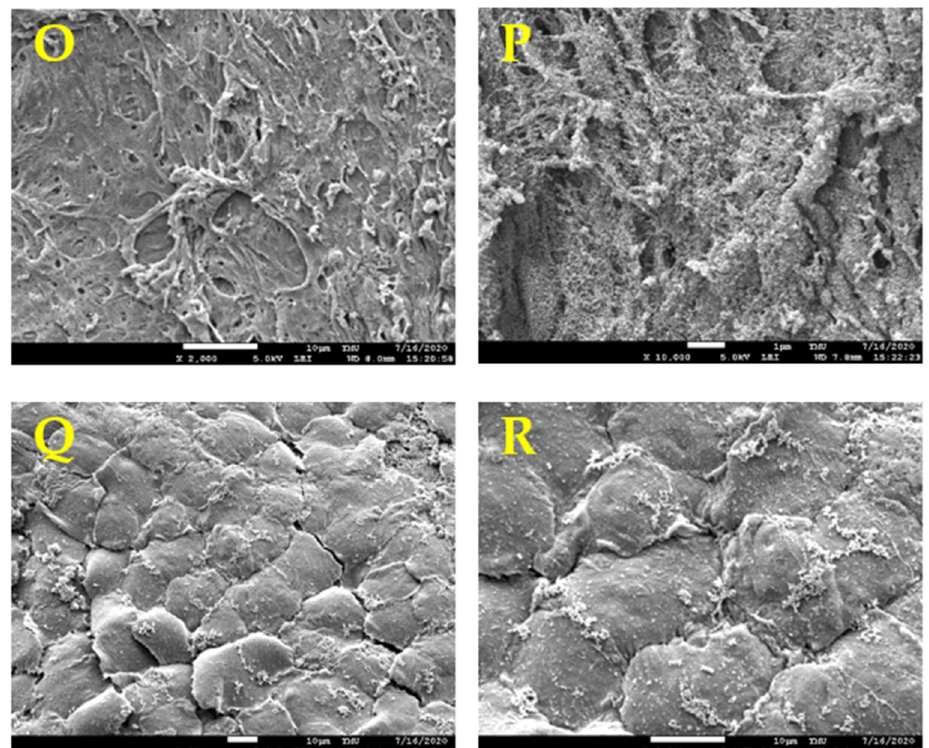
Figure 5. SEM of the luminal surface of HUA and sDHUAs seeded with HUVECs. ( A) –( B ) HUA, ( C) –( F ) sDHUA, 204 W, 4 h, ( G) –( J ) sDHUA, 204 W, 8 h, ( K) –( N ) sDHUA, 285 W, 2 h, ( O) –( R ) sDHUA, 285 W, 4 h. ( A) ,( C) ,( G) ,( K) ,( O ) Magnification: 2000×, Scale bar = 10 μ m; ( B) ,( D) ,( H) ,( L) ,( P )